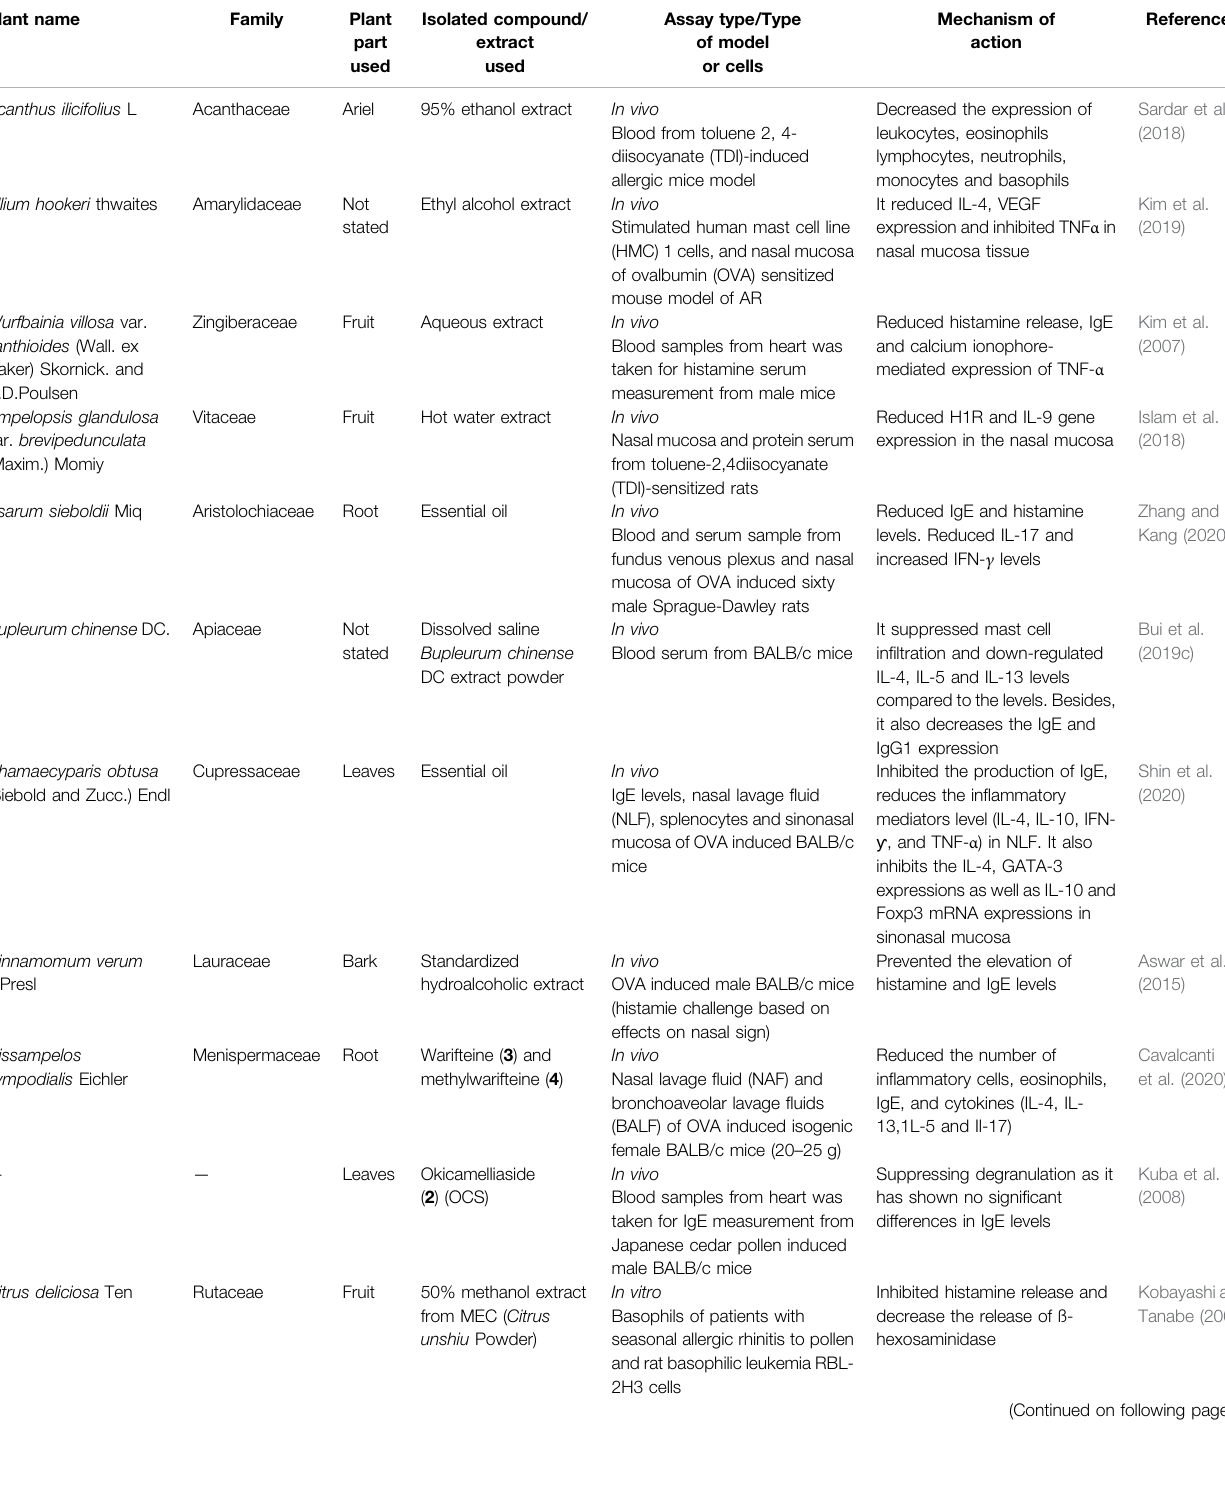
TABLE 1 | Plants with anti-allergic rhinitis effects in vivo and in vitro